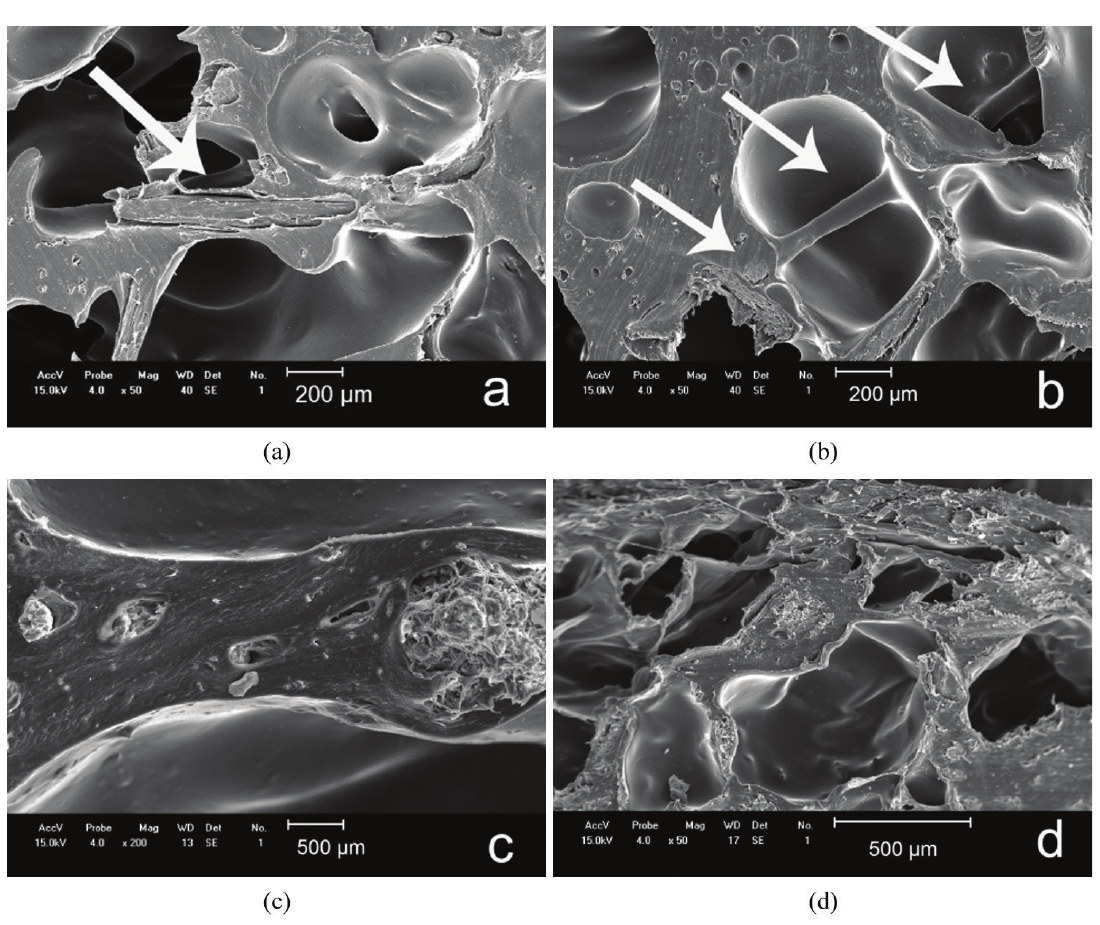
Figure 4. SEM images: (a) and (b) two locations of e-EVA/BF-20 at 50 × magnification; (c) e-EVA/WF-20 at 200 × magnification; (d) surface (skin) of e-EVA/WF-20 at 50 ×